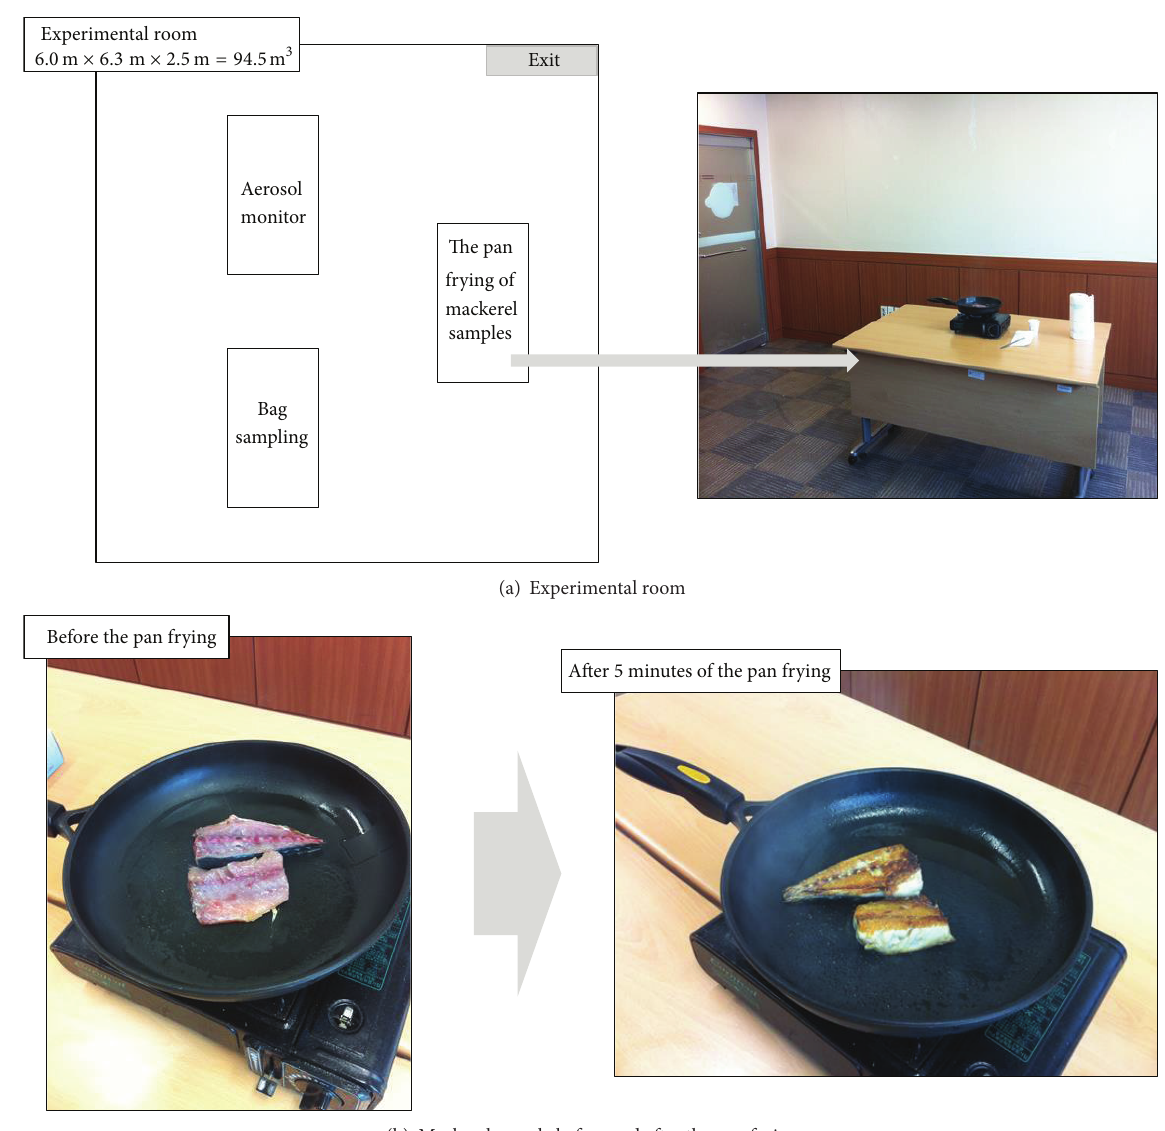
Figure 1: Photographs showing the mackerel samples investigated in this